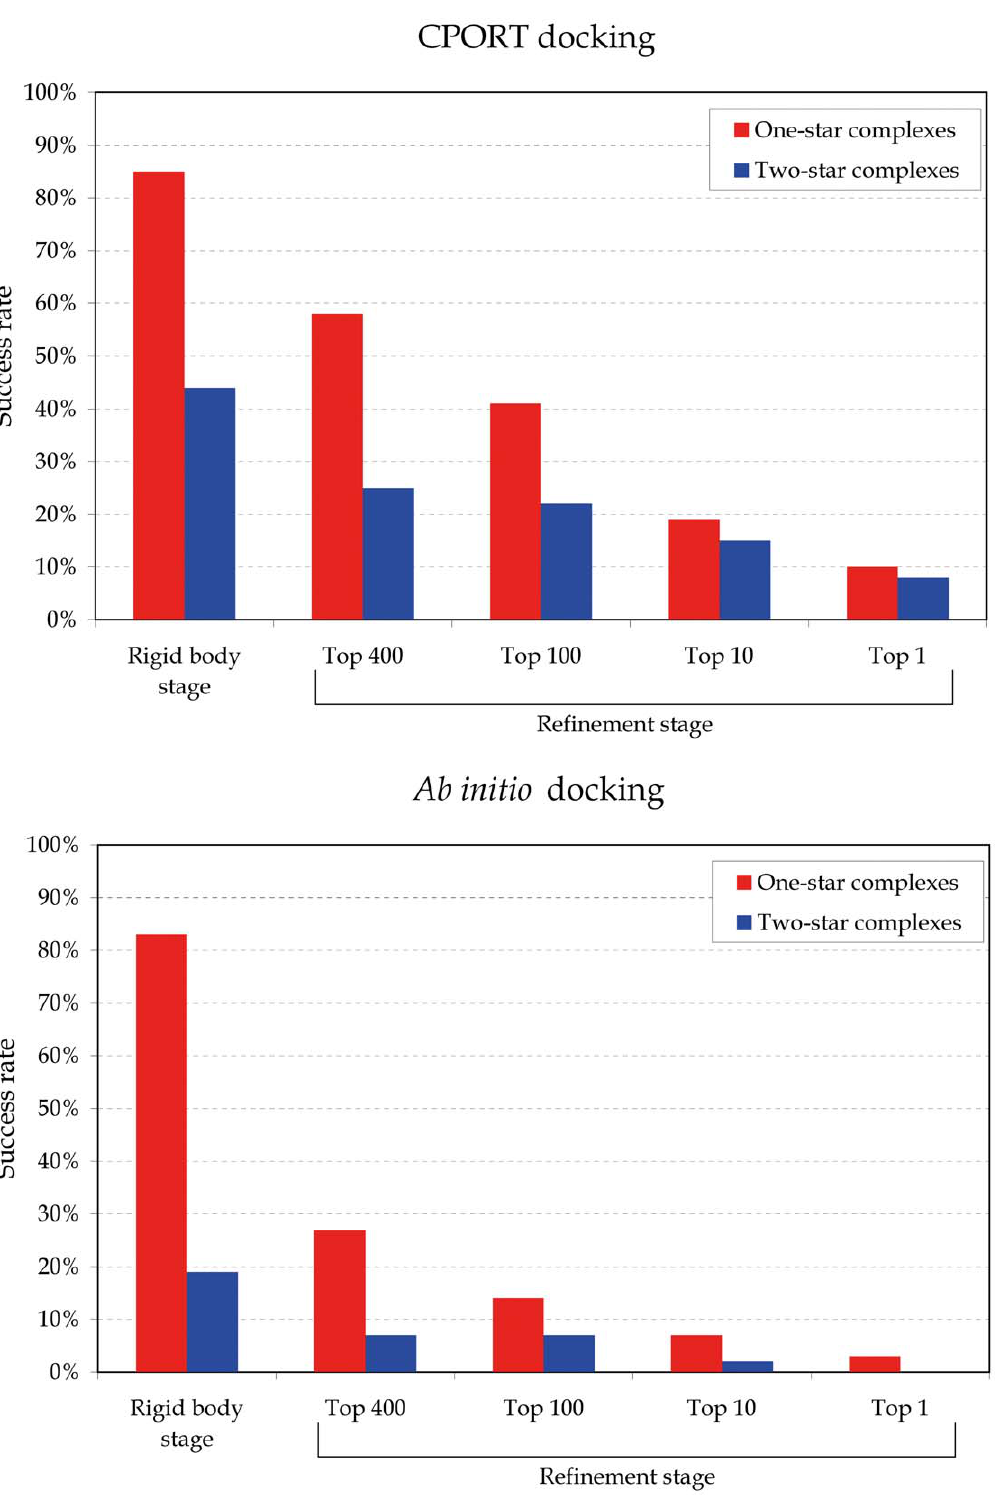
Figure 1. Docking results. Docking results for CPORT-driven docking using HADDOCK (top), compared to HADDOCK ab initio docking (bottom). The figure shows the percentage of cases for which at least one structure of that quality was generated during the rigid body stage (10 000 structures), and the top 400 (all refined structures), 100, 10 and 1 of the refinement stage. One-star and two-star criteria correspond to the CAPRI [18] definitions (see Methods). For the rigid body stage, the fnat criterion is not taken into account.